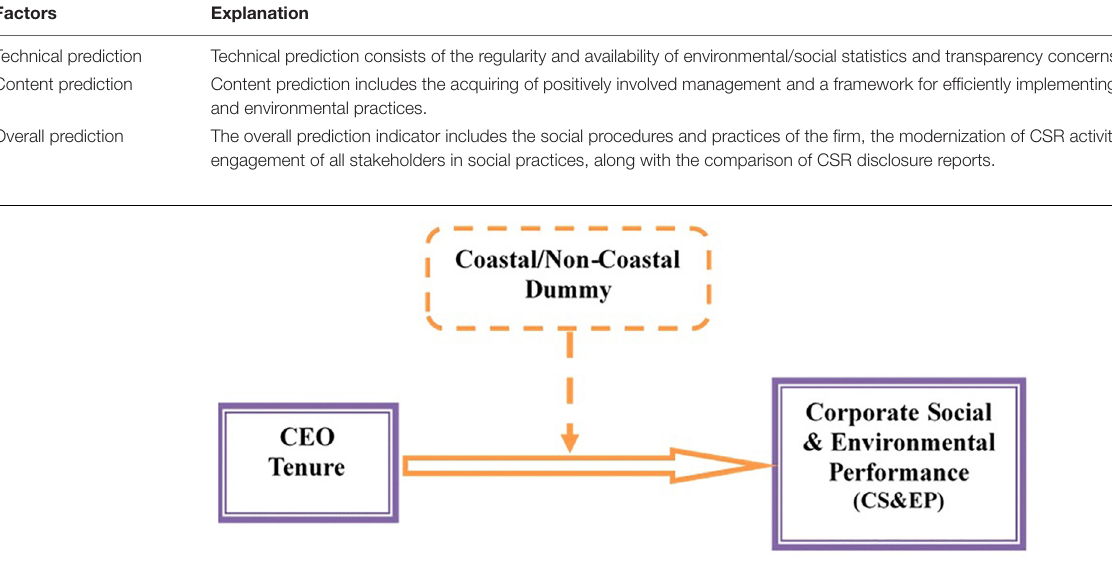
TABLE 1 | Three indicators from the Rankins (RKS) dataset.